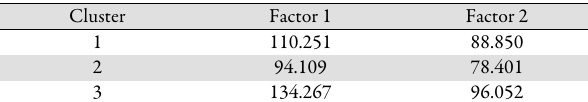
Table 7. The average of traits for achieved groups from cluster analysis, based on factor analysis in 20 spring wheat cultivars under drought stress